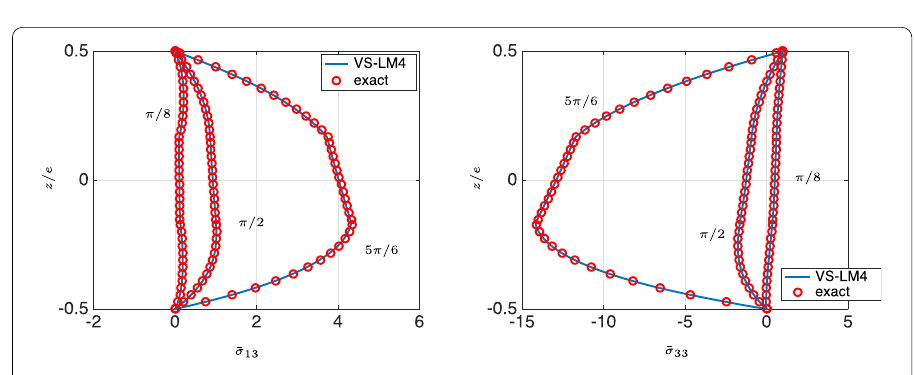
Bending analysis of laminated shells under a sinusoidal pressure Cross-ply test